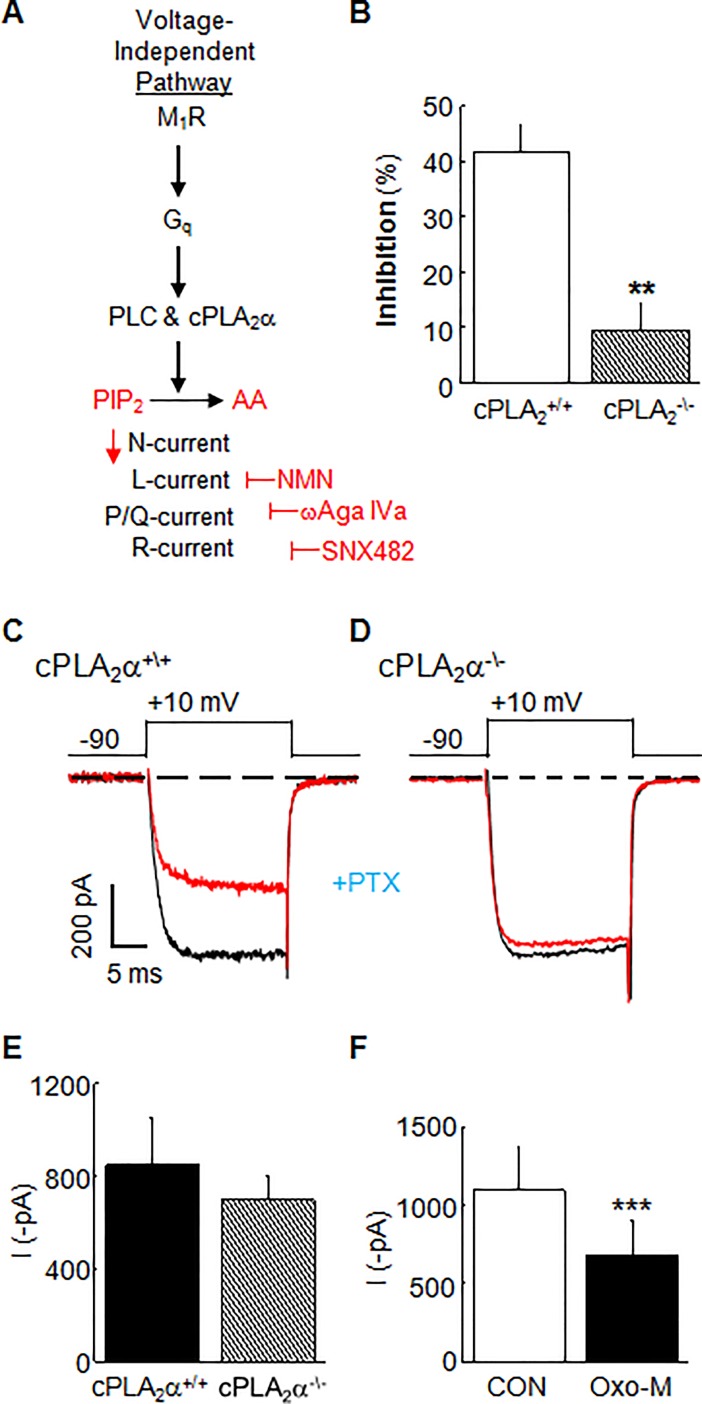
Oxo-M elicits reduced N-current inhibition in cPLA2α-\- SCG neurons.(A) Schematic of conditions used to isolate N-current in mouse SCG neurons. Cells were preincubated in PTX at least 5 hours prior to recording. (B) Summary bar graph of average N-current inhibition by Oxo-M in cPLA2α-\- and cPLA2α+\+ SCG neurons. **p ≤ 0.0015, cPLA2α-\- % inhibition compared to cPLA2α+\+ % inhibition using a two-tailed, t-test for two means (n = 5). Individual current traces from (C) cPLA2α+\+ compared to (D) cPLA2α-\- SCG neurons. Black traces, Control; red traces, Oxo-M. (E) Summary of average whole-cell N-current amplitude (NS, p ≥ 0.44, n = 5). (F) Summary bar graph showing that in the absence of PTX, significant membrane-delimited N-current inhibition by Oxo-M remains in cPLA2α-\- SCG neurons remains (***p ≤ 0.00005, n = 10).